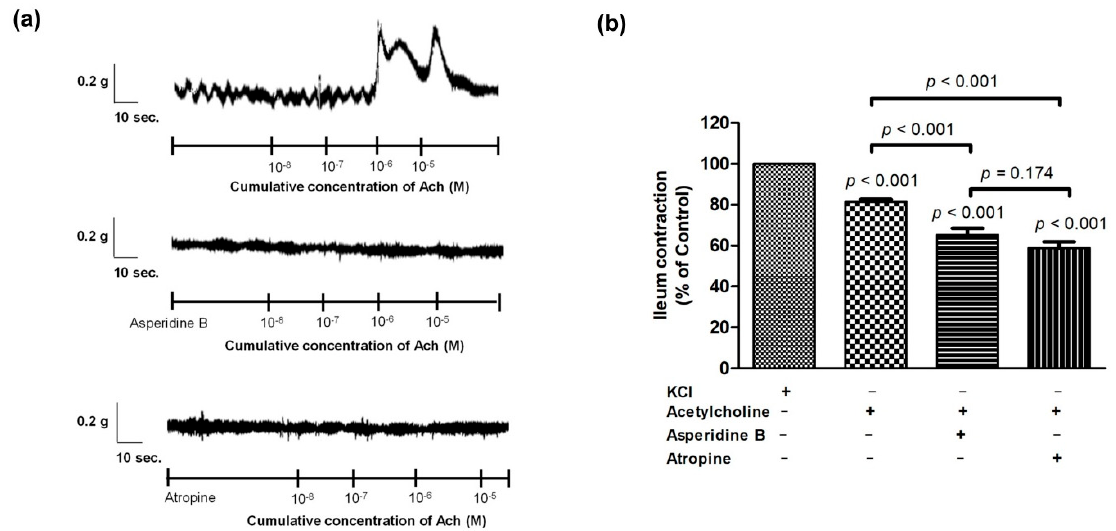
Figure 4. ( a ) Representative tracing and ( b ) activity of the contractile response of acetylcholine (10 − 8 –10 − 5 M) in the absence or presence of asperidine B or atropine. Effect of acetylcholine (10 − 5 M)-induced contractions in the absence or presence of asperidine B or atropine ( n = 6). The differences of the tested compounds, except specific comparator, indicated that it compared with KCl.